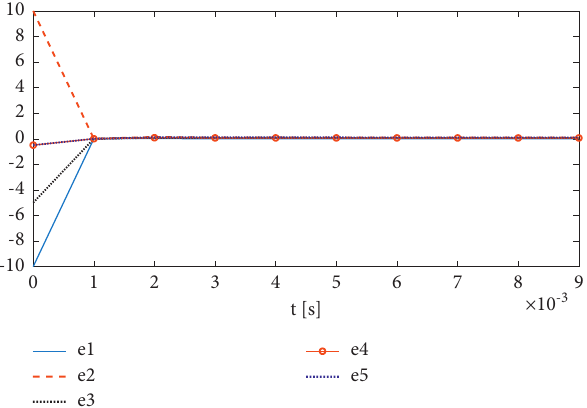
Figure 11: Error dynamics of the synchronization process.